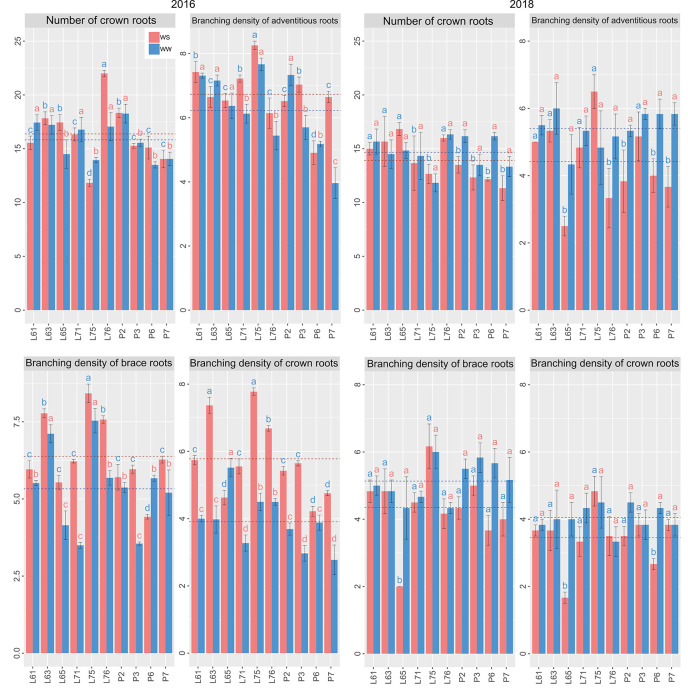
Root traits of popcorn inbred lines under WS and WW conditions in CS 2016 and 2018. Mean genotypes, red (WS) and blue (WW), followed by the same letter do not differ using the Scott and Knott test at 5%. The bars denote the standard error.